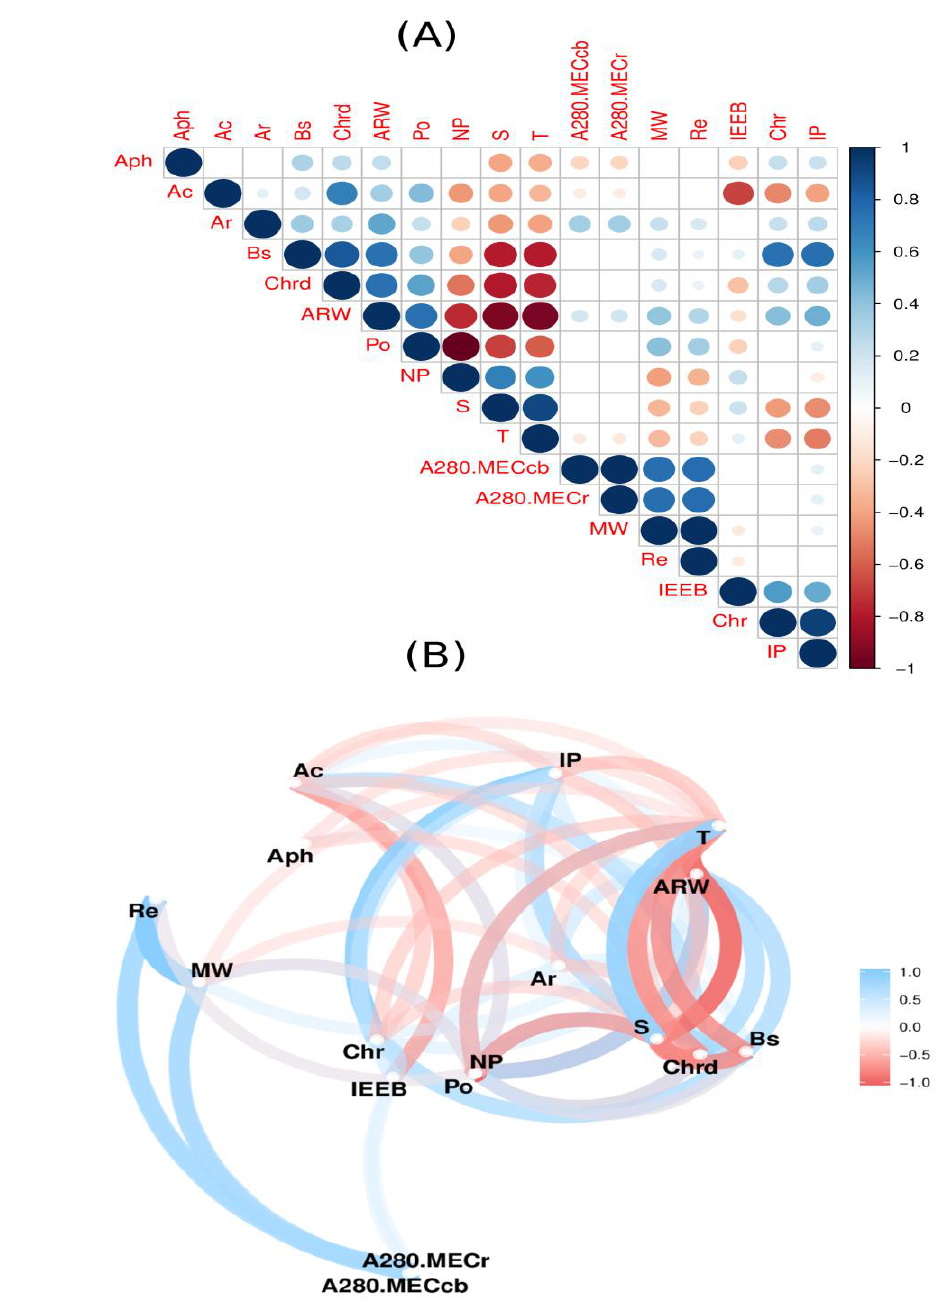
Figure 4 :Statistical correlation between different chemical and physical properties of anti-fungal proteins; (A) the heatmap of inter-correlation matrix and (B) the correlation networks, where pvalue > 0.01 and R 2 > 0.3. Phylogenetic analysis and domain identification of anti-fungal